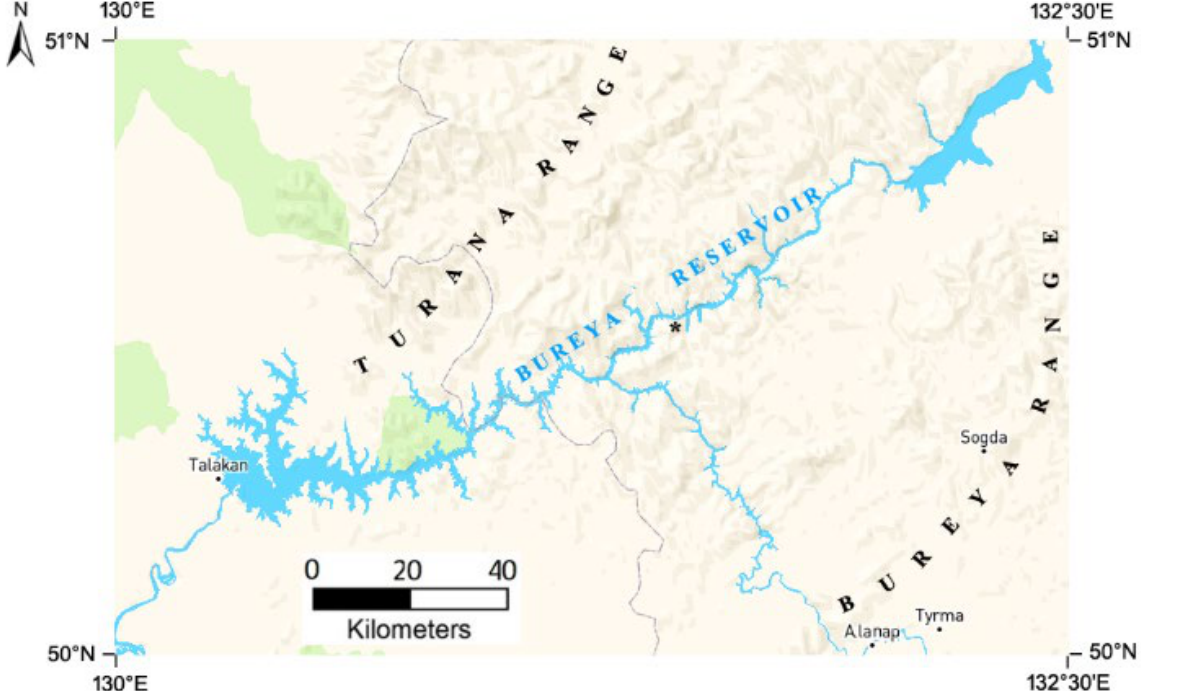
Figure 1. Orographic map of the landslide area (marked by an asterisk) with the Bureya water reservoir and surrounding mountain ranges.